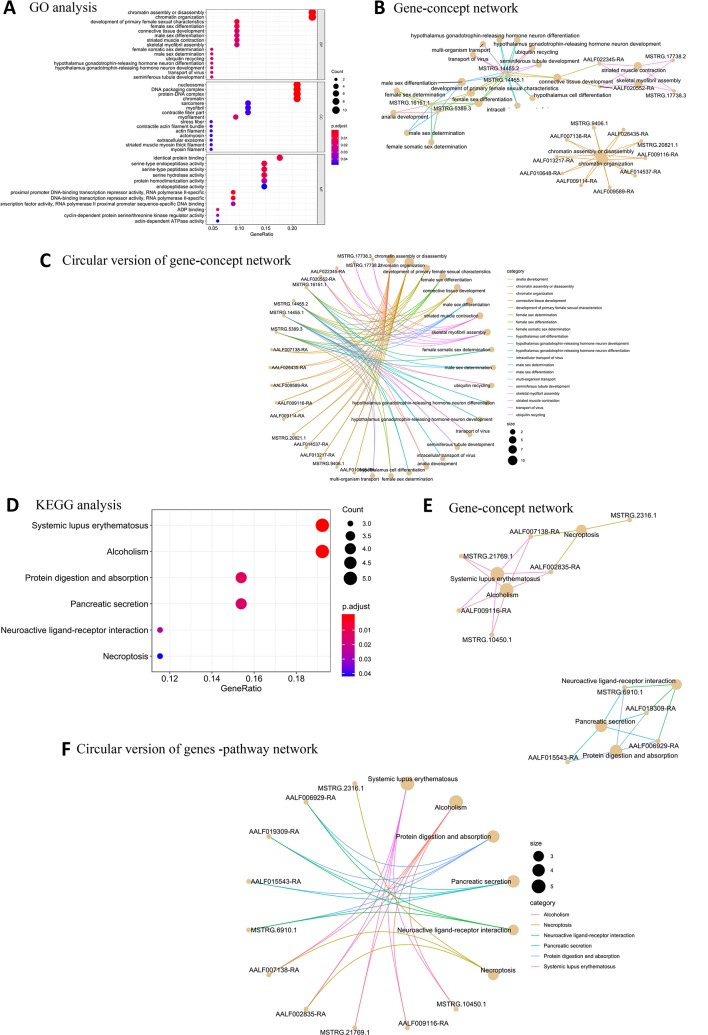
GO and KEGG pathway enrichment analysis of female high-expression protein-coding genes. (A) Top 20 GO terms for BP, CC, and MF for female high-expression protein-coding genes. (B) Gene-concept network depicting the linkages of female high-expression protein-coding genes and biological concepts as a network. (C) Circular version of female high-expression protein-coding gene-concept network. (D) Top KEGG pathway terms for female high-expression protein-coding genes. (E) Protein-coding gene-pathway network depicting the linkages of female high-expression protein-coding genes and KEGG pathways as a network. (F) Circular version of female high-expression protein-coding gene-pathway network.